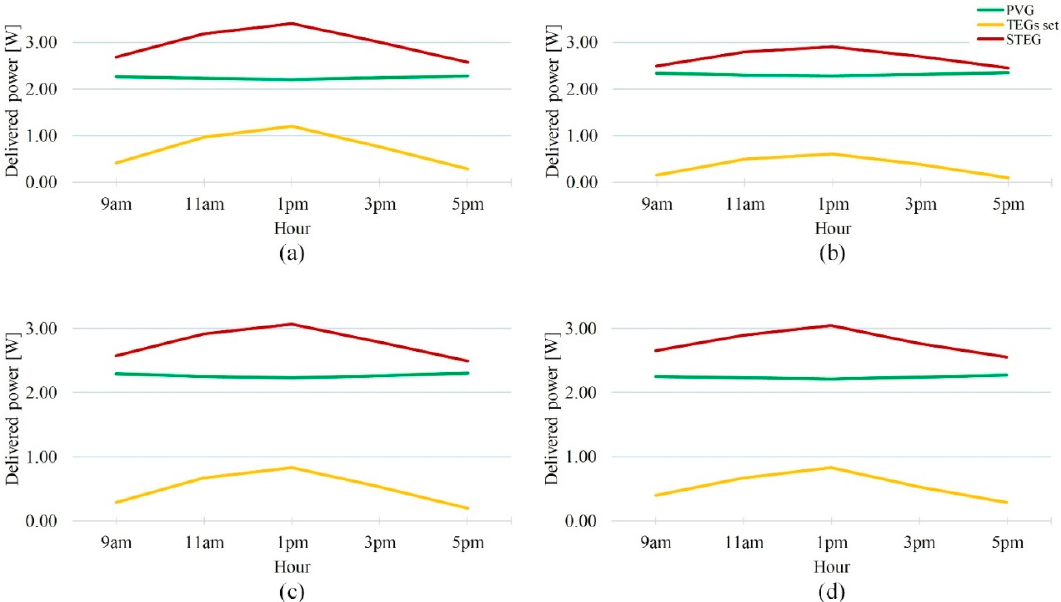
Figure 16. Power delivered from both STEG device and its constitutive elements ( a ) Fall equinox day, ( b ) Winter solstice day, ( c ) Spring equinox day, ( d ) Summer solstice day.